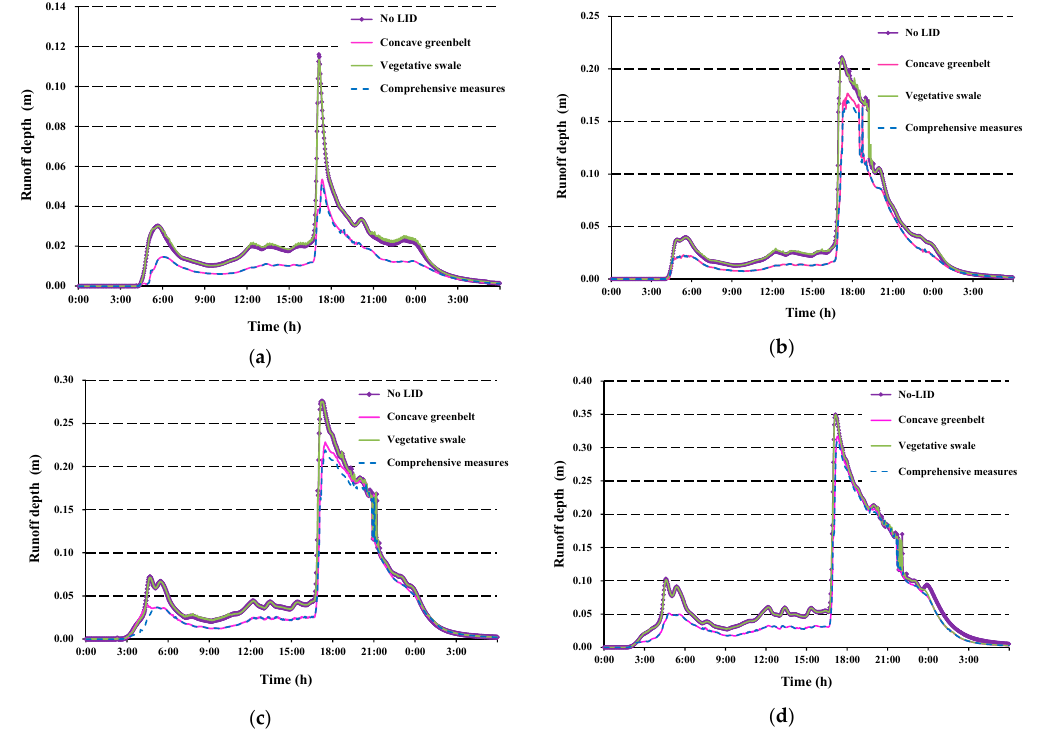
Figure 8. Simulated runoff processes in different scenarios with different return-period events: ( a ) one year; ( b ) two years; ( c ) five years; and ( d ) ten years. Table 9. Percentages of MRD reduction in different scenarios. Table 7. The simulated runoff and MRD in basic